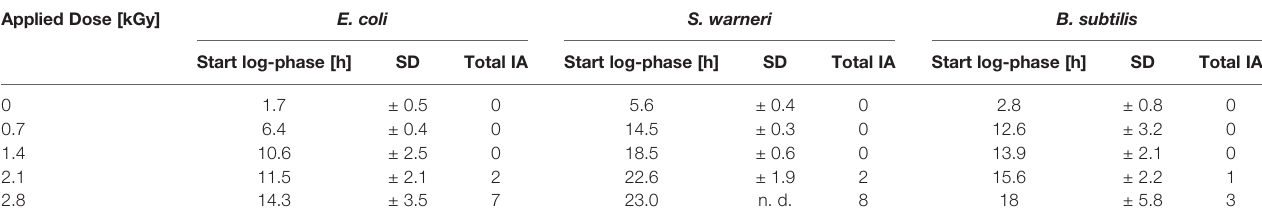
TABLE 3 | In fl uence of increasing dose values on the start of the exponential phase (start log-phase) given as mean value with the respective standard deviation (SD). Applied Dose [kGy] E. coli S.